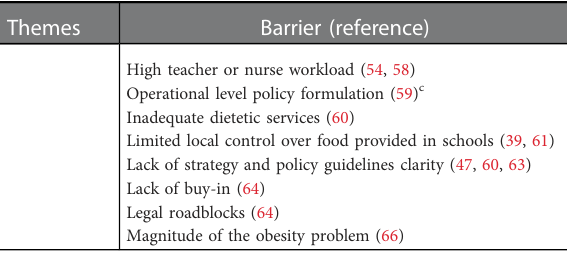
TABLE 3 Barriers of childhood obesity prevention policies